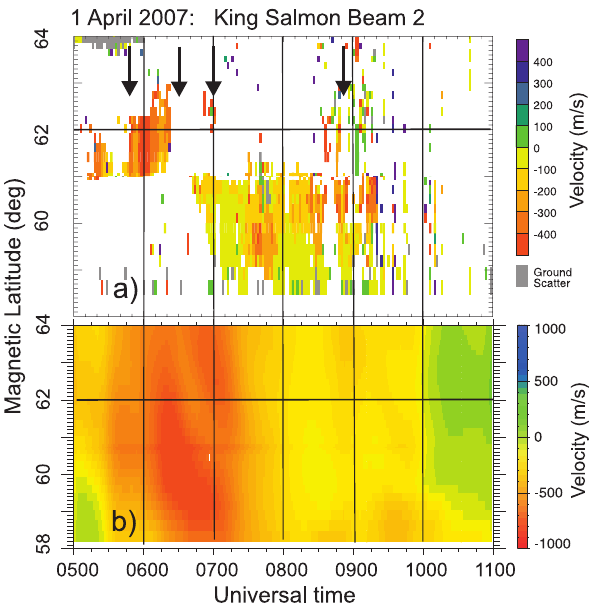
Fig. 7. The same as in Fig. 6 but for the King Salmon radar, beam 2. Auroral oval was located at 3 ∼ 64 ◦ , at the top of the